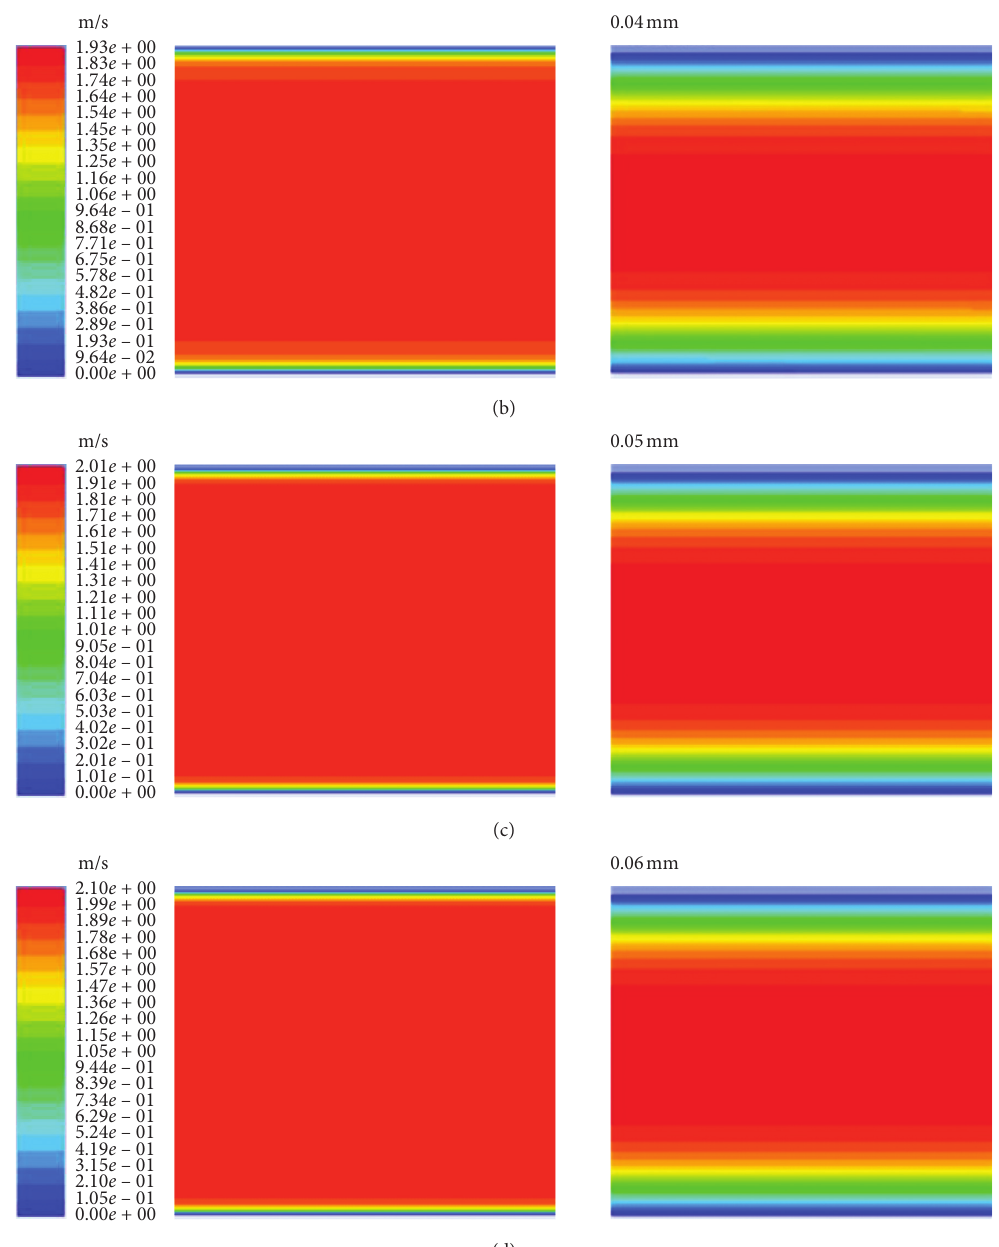
Figure 11: Vectors of velocity at inlet and outlet of end clearance flow field under different